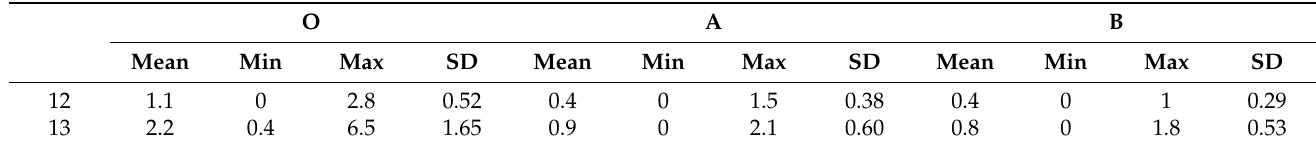
Table 10. Descriptive statistics of wind speed at each test point on the 12th and 13th (m/s).